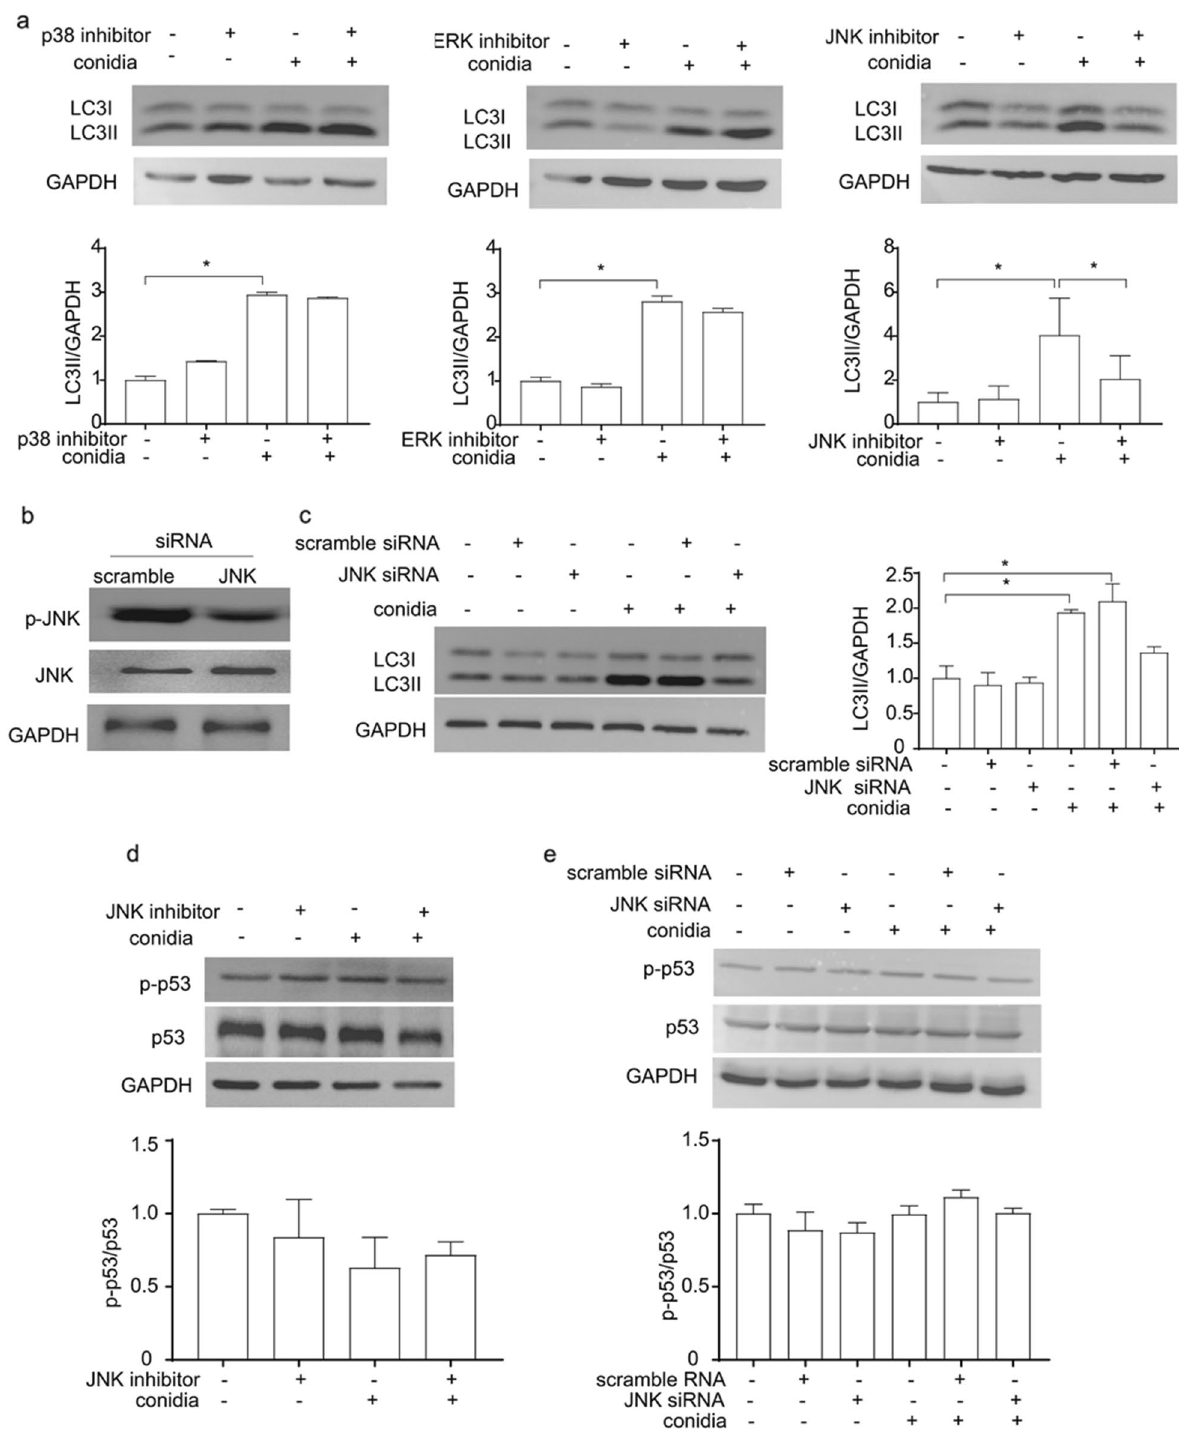
Figure 4. Involvement of JNK in A. fumigatus conidia-induced autophagy in bronchial epithelial cells. ( a ) After culturing with the corresponding inhibitor (20 μmol) for 1 h, the cells were stimulating with resting conidia for 8 h and the expression of LC3II was assessed. The blots were cut prior to hybridisation with antibodies during blotting. ( b ) Phosphorylation of JNK in BEAS-2B cells after transfected with scramble siRNA or JNK siRNA. ( c ) Expression of LC3II in BEAS-2B cells after transfected with scramble siRNA or JNK siRNA. ( d , e ) Prior to inoculation with A. fumigatus conidia for 8 h, BEAS-2B cells were treated with 20 μmol JNK inhibitor for 1 h, or transfected with siRNA targeting JNK for 36 h. Phosphorylation of p53 were measured by western blotting. The data shown as mean ± SD and represented 3 independent experiments. * P < 0.05; n.s. not